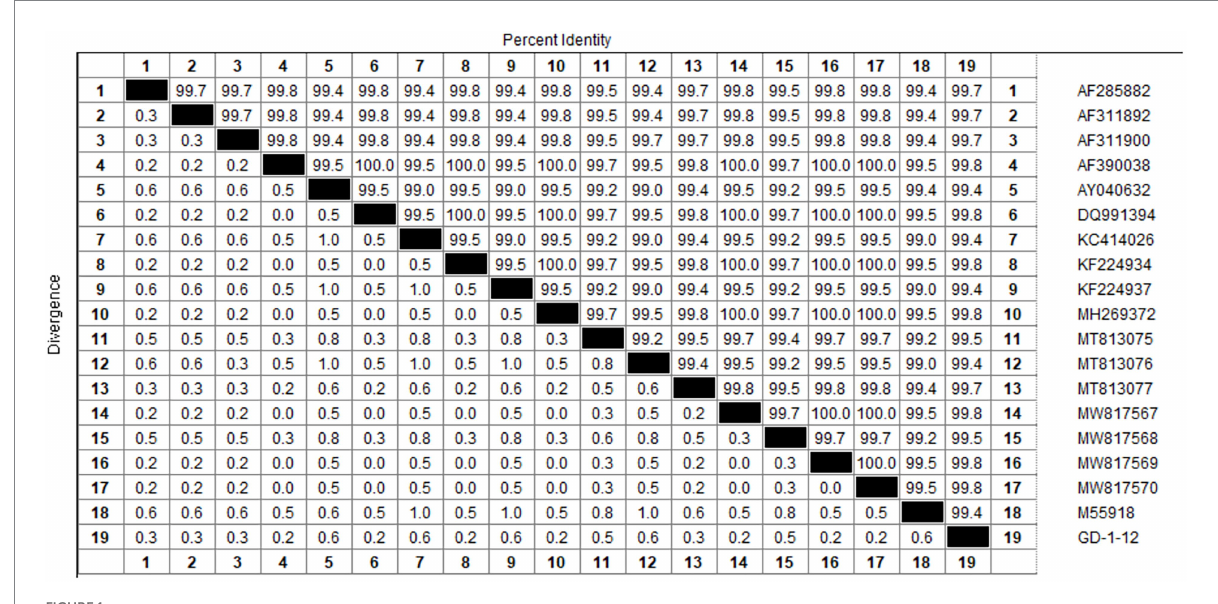
FIGURE 1 The multiple sequence alignment of the CIAV VP2 gene. Multiple sequence alignment using GD-1-12 as the reference strain revealed CIAV VP2 had greater homology than 99.4%. Both MEGAX64 and Megalign of DNASTAR used were default parameters. RAA, recombinase-aided amplification